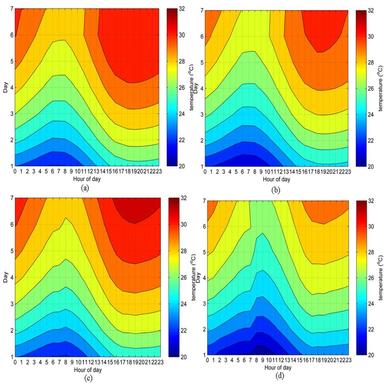
Temperature comparison between optimal cases with different optimization algorithms: (a) solar cell temperature, t14, through the PSO; (b) solar cell temperature, t14, through the TLBO; (c) PCM temperature, t16, through the PSO; (d) PCM temperature, t16, through the TLBO. (Note: t14 and t16 refer to the solar cell temperature and the PCM temperature, as shown in the (b).)